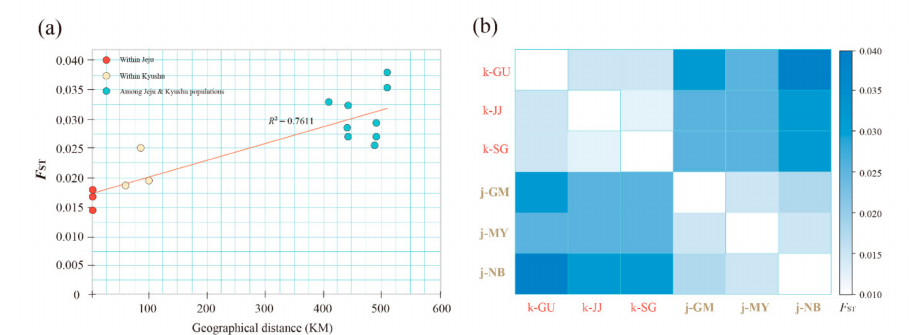
Figure 6. The genetic di ff erentiation for the six populations of Quercus gilva . ( a ) Mantel tests between F ST values and geographical distance among populations; ( b ) distance matrix of pairwise F ST between populations.